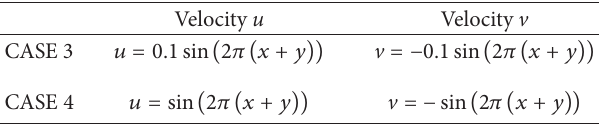
Table 3: Velocity expressions of the two-dimensional